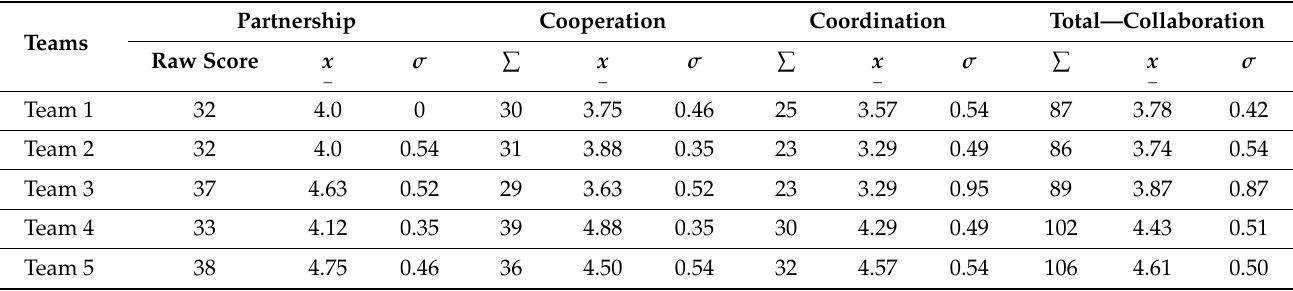
Table 1. Sum of Scores: Means and Standard Deviations for AITCS-II.